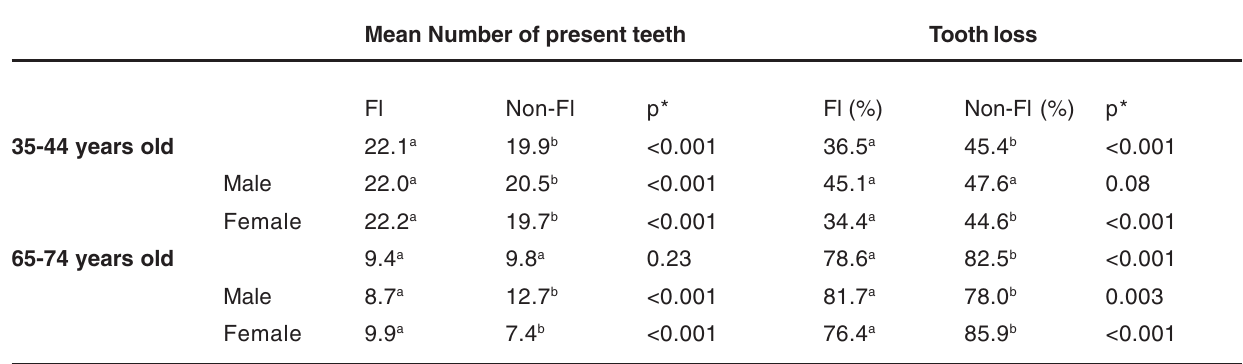
TABLE 2- Number of present teeth and percentage of tooth loss (M-T component of DMF-T) according to age group and